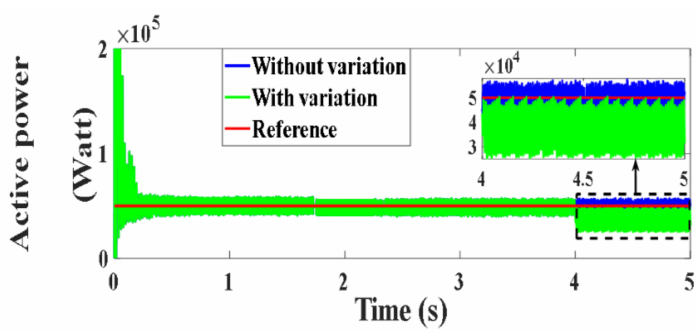
Figure 163. Active power under PVC (Watt).